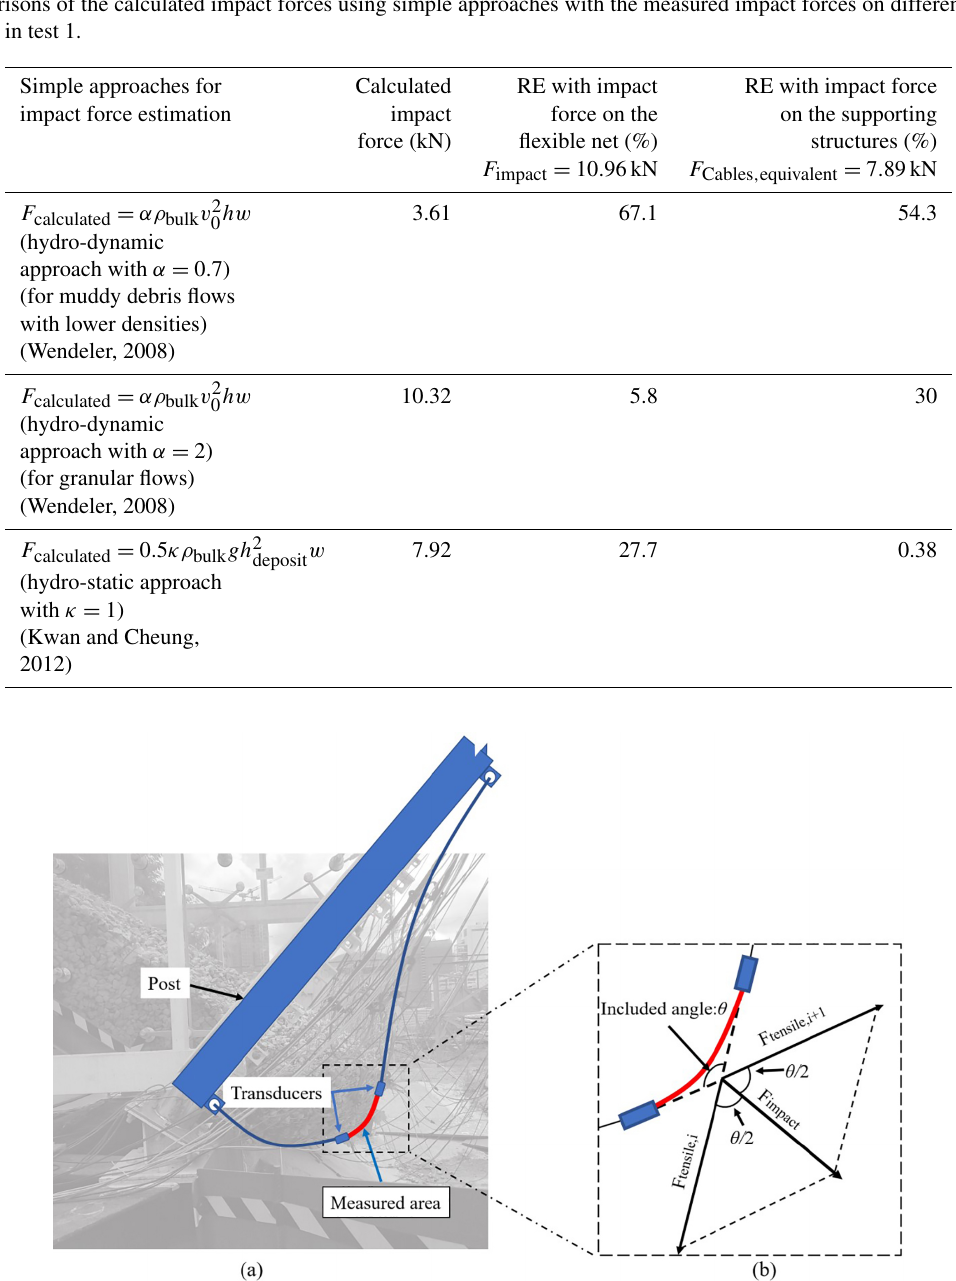
Figure 11. (a) Sketch of the flexible barrier under the impact of a granular flow and (b) the simplified force analysis of the measured area in the cross section of transducer i and transducer i +